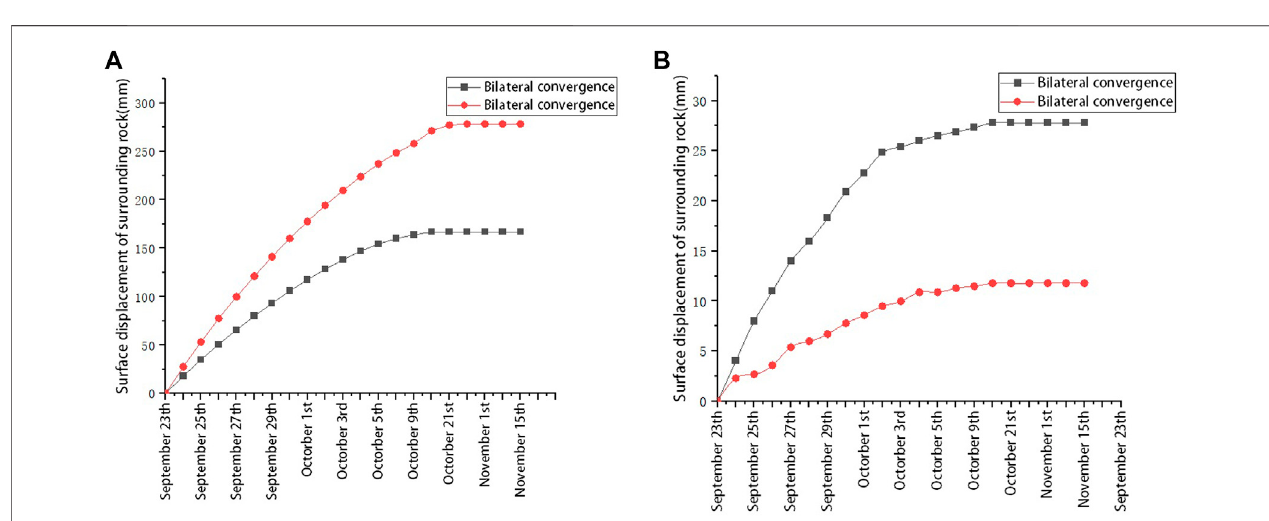
FIGURE 7 | Monitoring chart of 5,921gob-side entry retaining deformation. (A) During the drivage, (B) during the left lane.